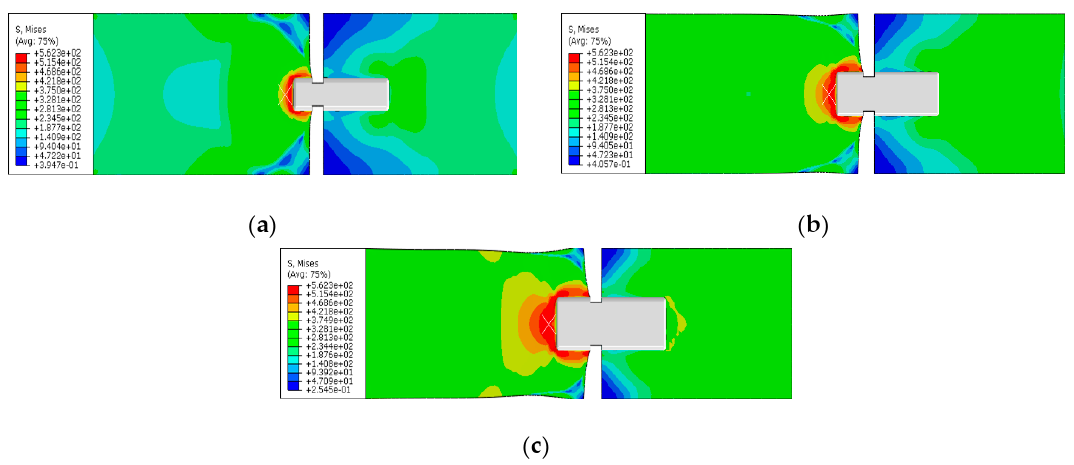
Figure 5. Fracture shape and stress distribution in the ultimate strength of analysis results: ( a ) FT20L20 (Displacement = 4.07 mm, Pua = 80.77 kN), ( b ) FT30L30 (Displacement = 8.25 mm, Pua = 113.80 kN), ( c ) FT40L40 (Displacement = 17.32 mm, Pua = 134.56 kN).